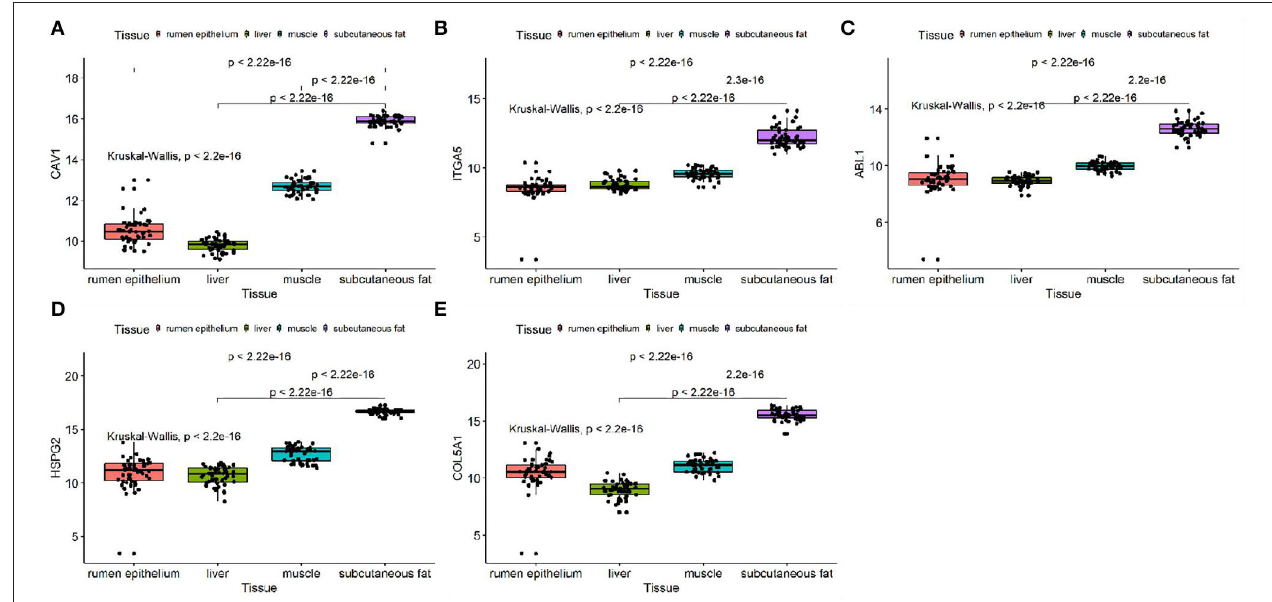
FIGURE 8 | Expression of Hub genes in dataset GSE116775. (A–E) Expression levels of (A) CAV1, (B) ITGA5, (C) ABL1, (D) HSPG2, and (E) COL5A1 were significantly increased in Subcutaneous fat tissue.